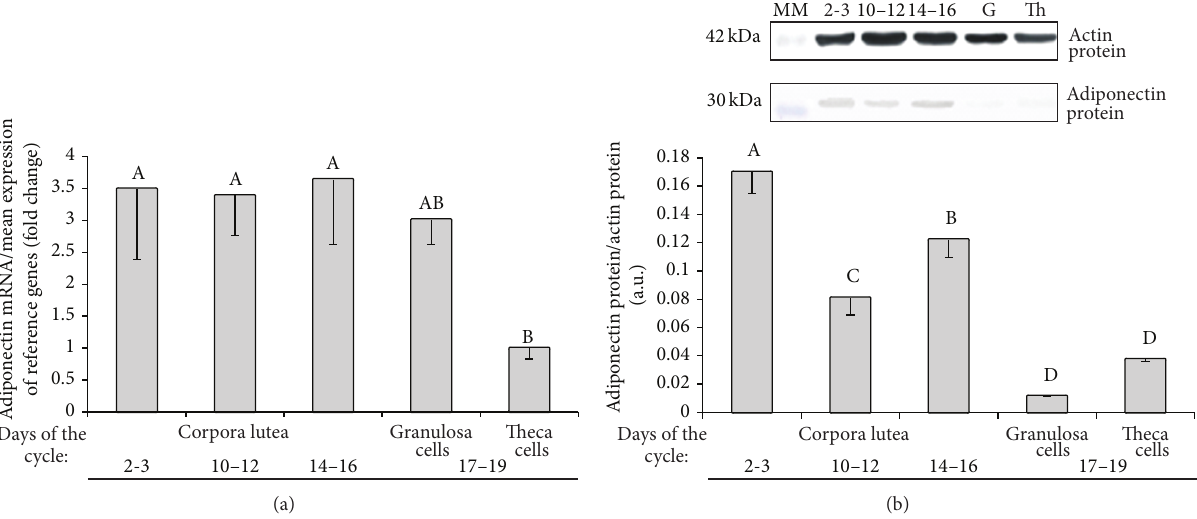
Figure 1: (a) Adiponectin mRNA expression determined by quantitative real-time PCR in porcine corpora lutea, granulosa cells, and theca interna cells harvested on days 2-3, 10–12, 14–16, and 17–19 of the oestrous cycle. The results are expressed as means ± S.E.M. ( 𝑛 = 5 ). Bars with different letters at the top are different ( 𝑃 < 0.05 ). (b) Adiponectin protein expression determined by Western blotting analysis in porcine corpora lutea, granulosa, and theca interna cells on days 2-3, 10–12, 14–16, and 17–19 of the oestrous cycle. Upper panel: representative immunoblots (MM—molecular marker, G—granulosa cells, Th—theca interna cells); lower panel: densitometric analysis of adiponectin protein relative to actin protein. The noted values are expressed as means ± S.E.M. in arbitrary optical density units ( 𝑛 = 5 ). Bars with different letters at the top are different ( 𝑃 < 0.01 ).